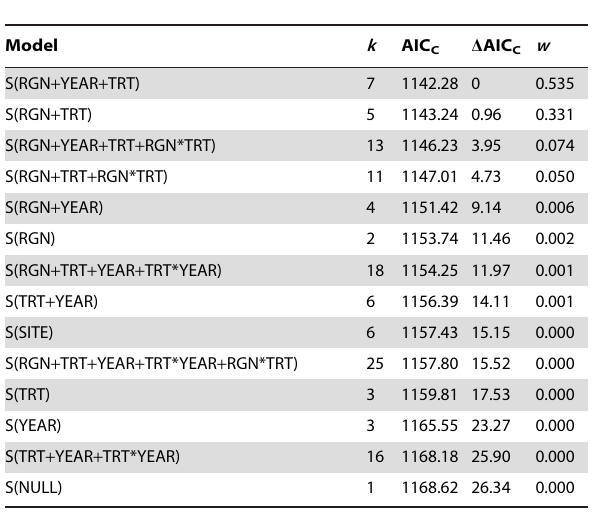
Figure 4. Body mass of male cerulean warblers by treatment after controlling for age, year, and site, 2008–10. Different letters indicate significant differences ( P # 0.05) between respective treatments. Error bars represent 6 1 SE and numbers above bars indicate sample size. doi:10.1371/journal.pone.0052107.g004 Table 2. Model selection results for factors influencing daily survival rate of cerulean warbler nests.